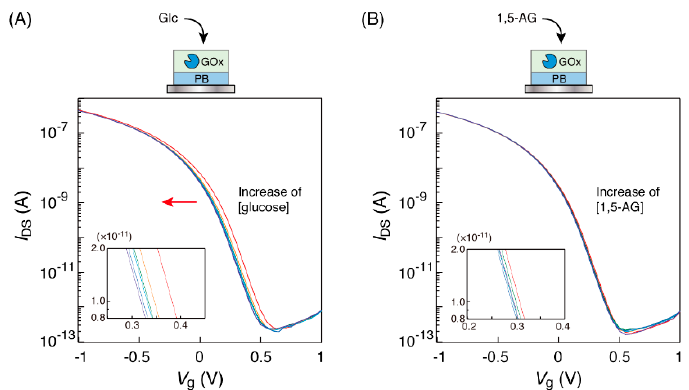
Figure 2. Transfer characteristic curves of the organic field-effect transistor (OFET) biosensor with a GOx-PB electrode obtained in response to the electrode’s immersion into ( A ) glucose and ( B ) 1,5-AG solutions at different concentrations (0, 0.1, 0.5, 1, 3 and 10 mM), buffered by 1×PBS at 25 °C. Each concentration curve has been indicated in red (0 mM), orange (0.1 mM), green (0.5 mM), light blue (1 mM), blue (3 mM) and purple (10 mM), respectively. The insets show the enlarged views.